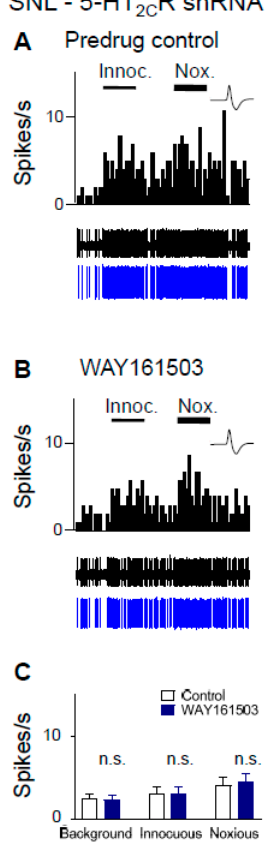
Figure 7. Excitatory effects of a 5-HT 2C R agonist (WAY161503) were eliminated by 5-HT 2C R knockdown in neuropathic rats. CeA neurons were recorded in SNL rats 2 weeks after 5-HT 2C R shRNA was injected into the BLA, i.e., 4 weeks post SNL surgery. Background activity and evoked responses to innocuous (100 g/6 mm 2 ) and noxious (500 g/6 mm 2 ) stimulation of the left hindpaw are shown. ( A , B ) WAY161503 (100 µM concentration in microdialysis fiber; 15 min; ( B )) had no effect in an individual CeA neuron compared to predrug control (ACSF; ( A )). Same display as in Figures 3 and 4. ( C ) Summary of lack of significant facilitatory effects of WAY161503 on CeA neurons ( n = 6 neurons; p > 0.05, paired t -test compared to predrug).